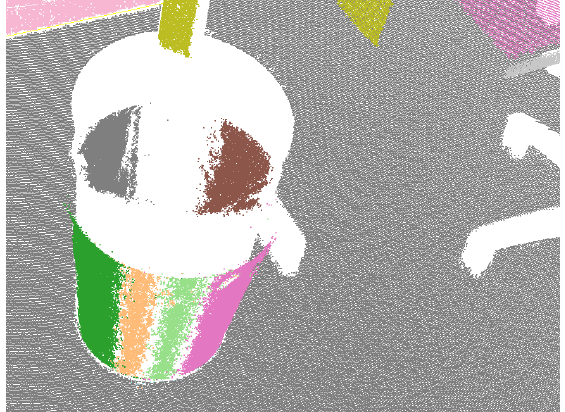
Figure 9. The curved bin over- segmented into the set of nearly planar